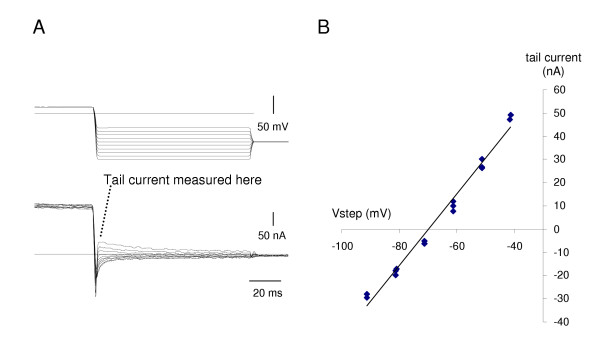
Reversal of the outward current in the B1 motoneuron. A. Following a 400 ms step to +15 mV, activating the outward current, the voltage was stepped down and the amplitude of the tail current measured immediately upon settling. Upper trace: voltage clamp output, lower trace current. B. The tail current is approximately linear with voltage between -80 and -40 mV, with some rectification, and reverses at -70 mV. In 4 replicate preparations, the mean reversal potential was -67 ± 2.6 mV.